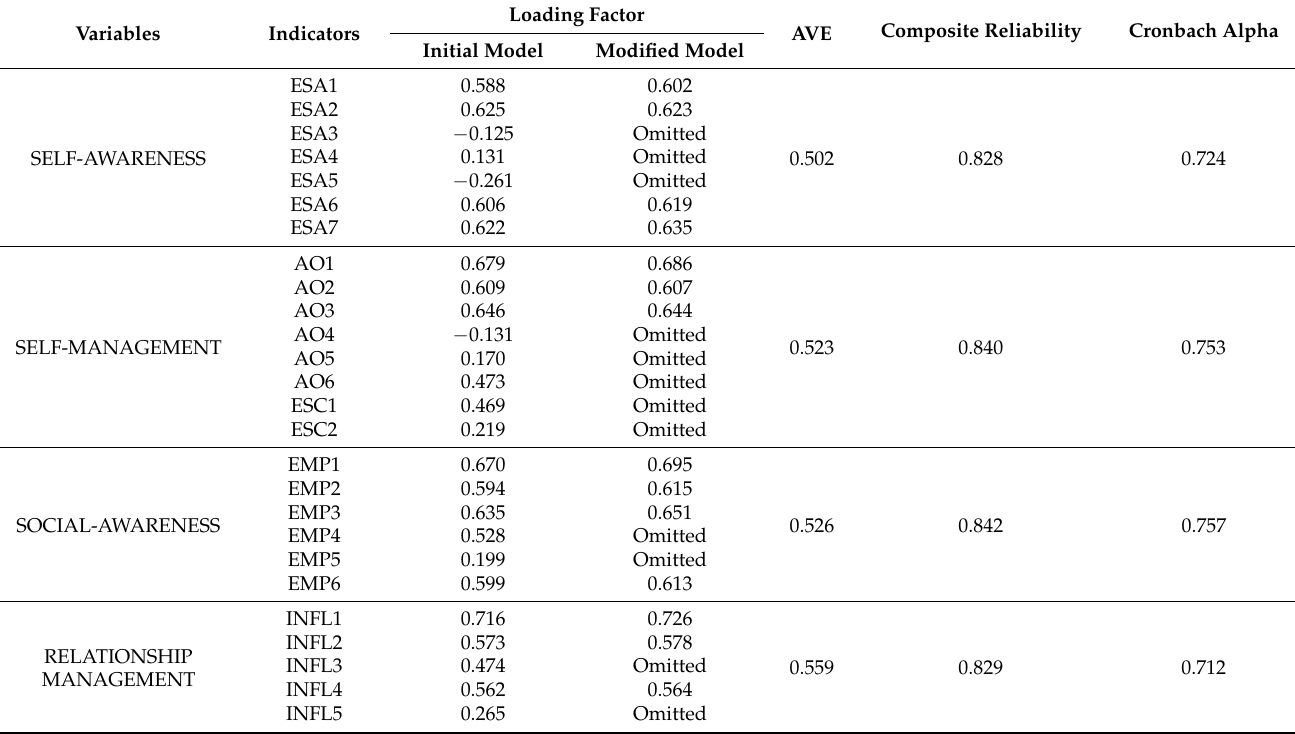
Table 3. Construct Validity of the Measurement Model for Emotional Intelligence